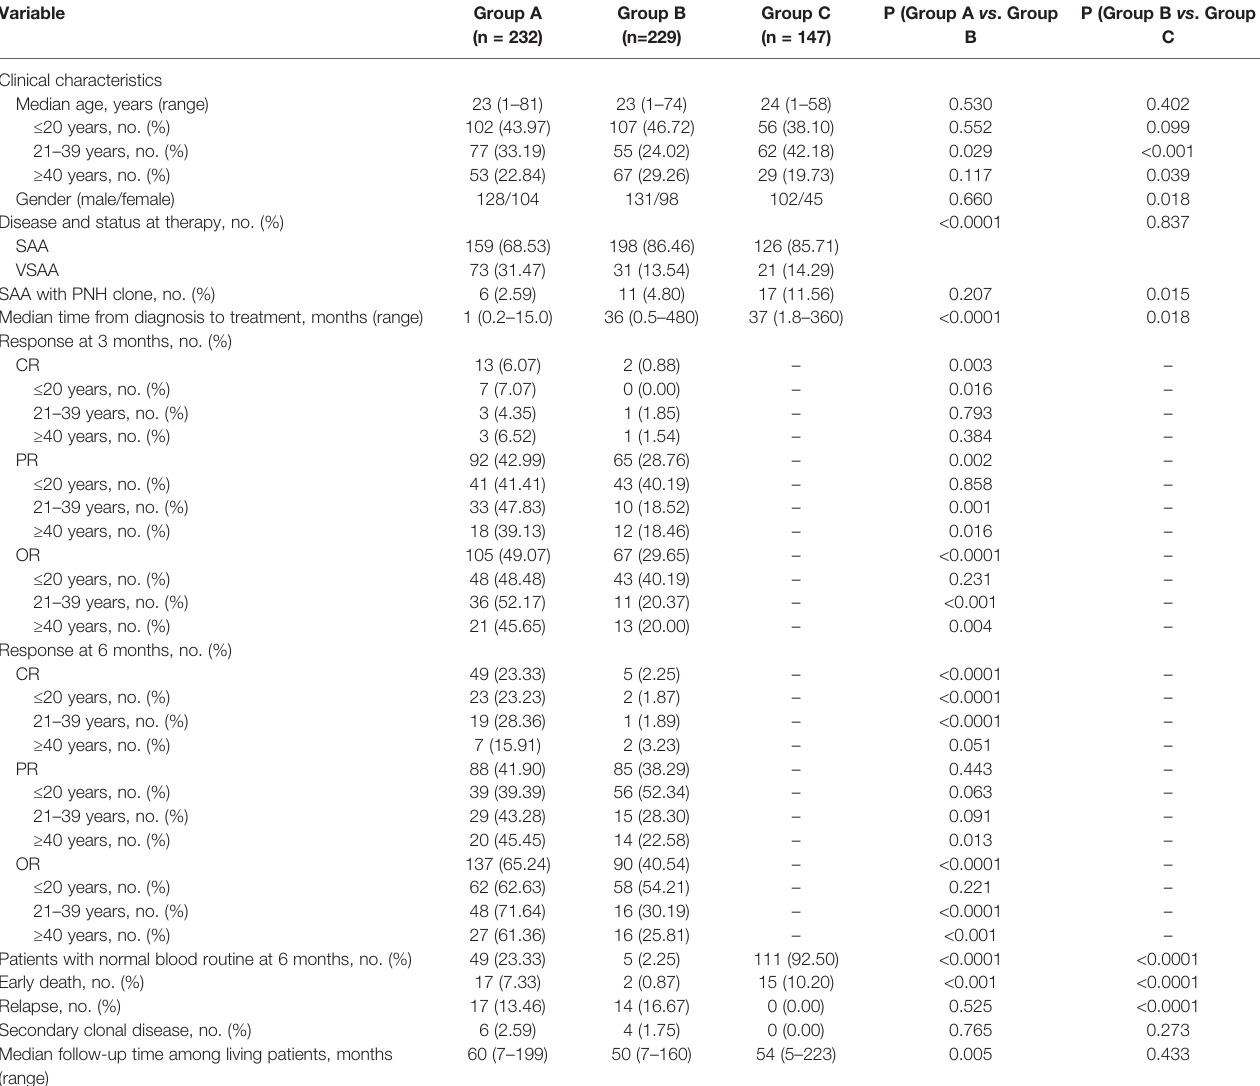
TABLE 1 | Characteristics of SAA patients and clinical outcomes after treatment.